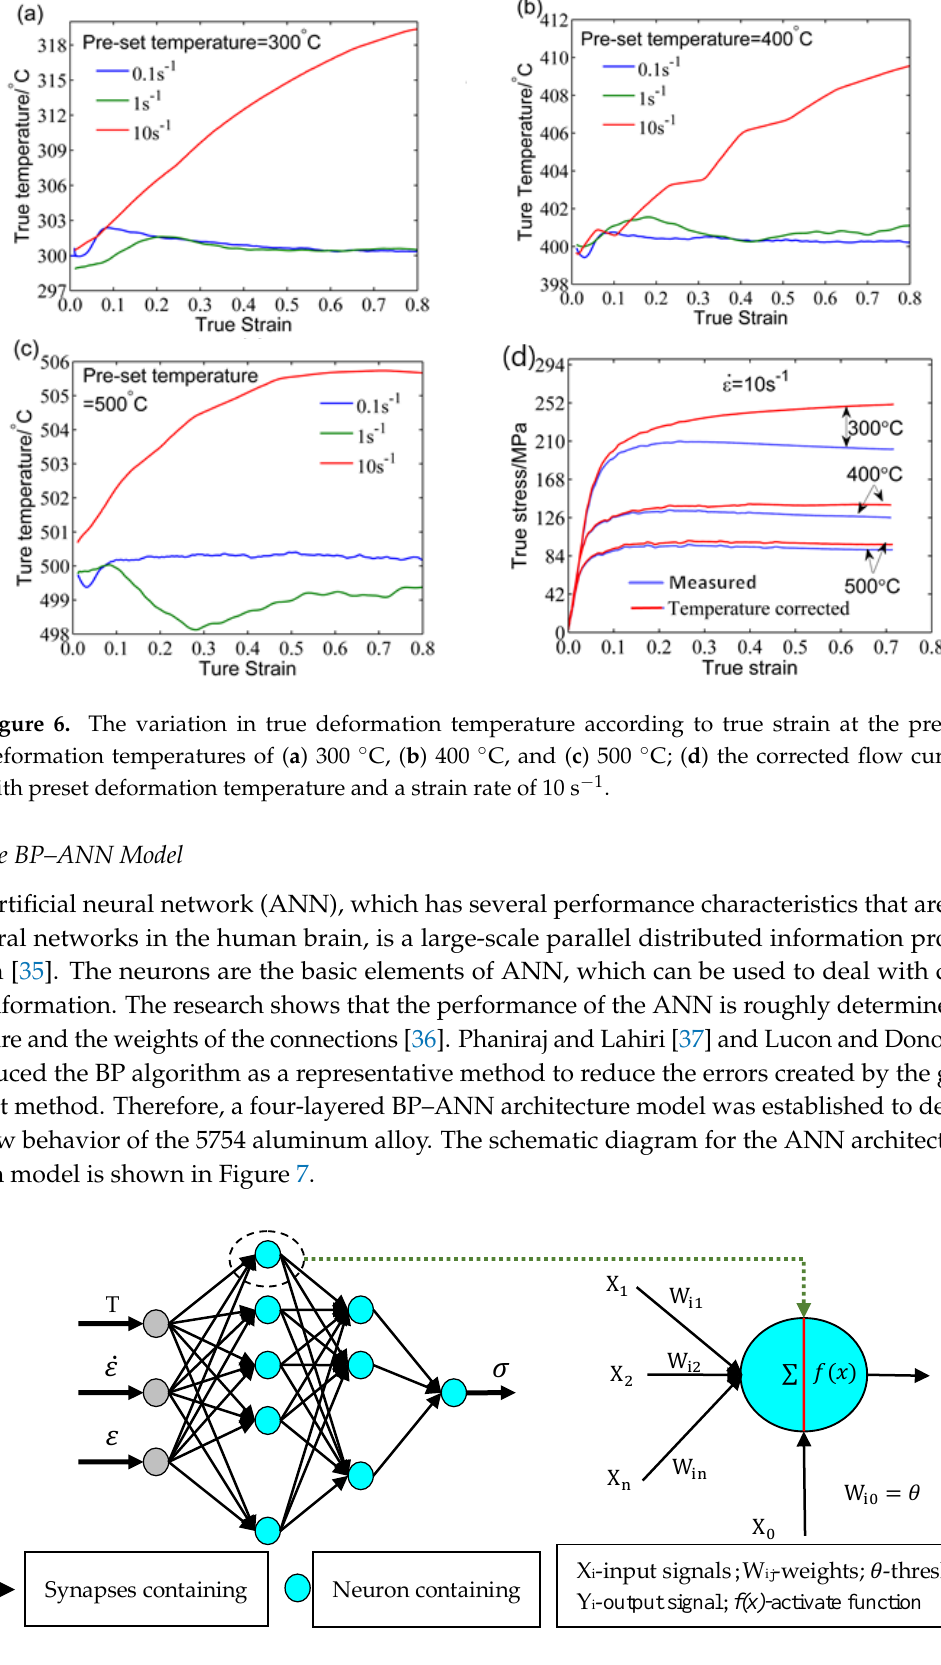
Figure 7. The structure of the artificial neural network (ANN) model and the neuron model.